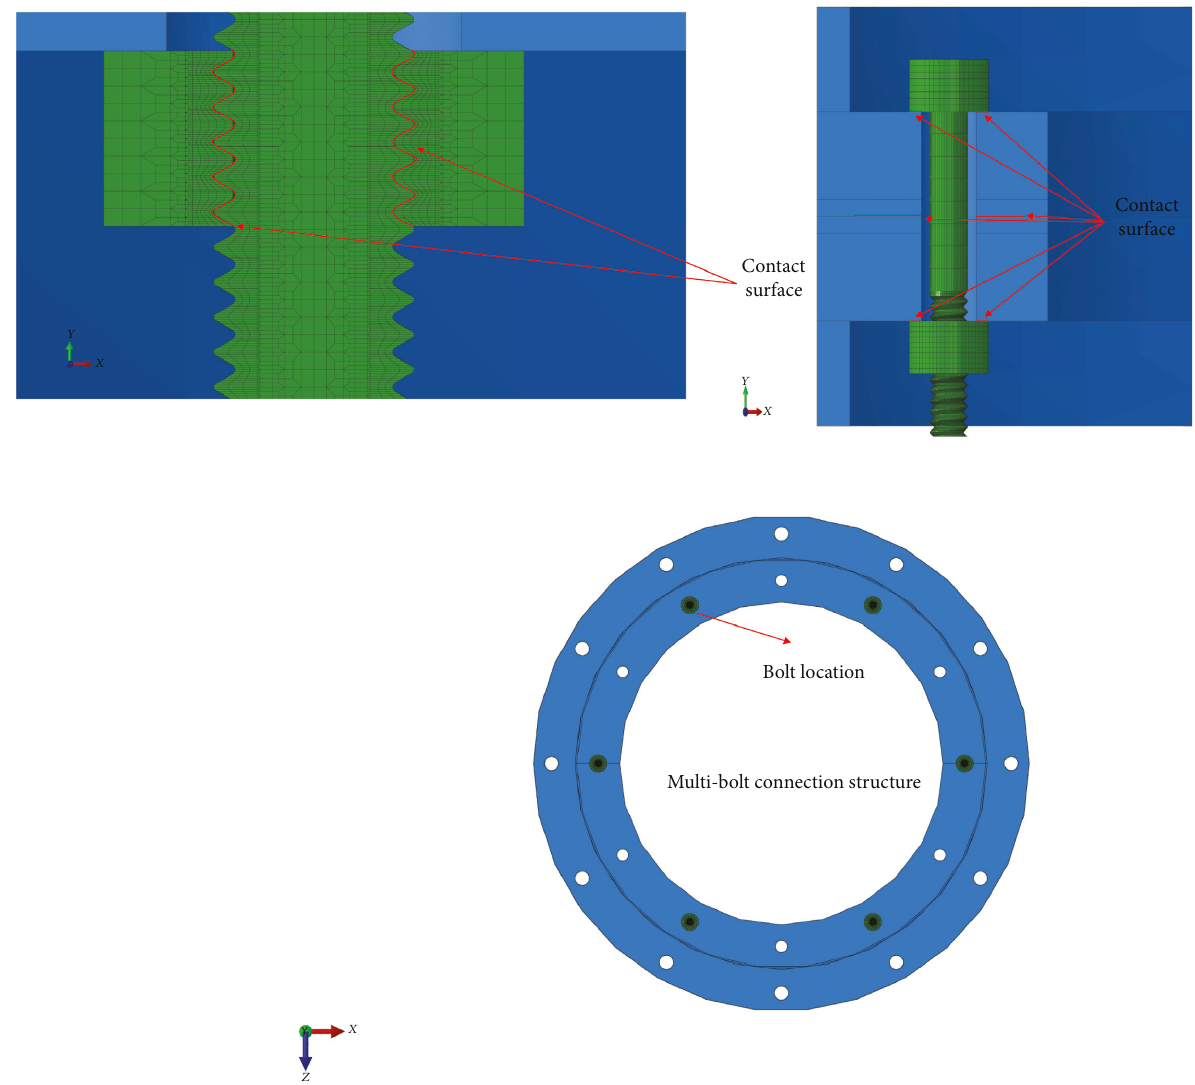
Figure 4: Connection structure contact